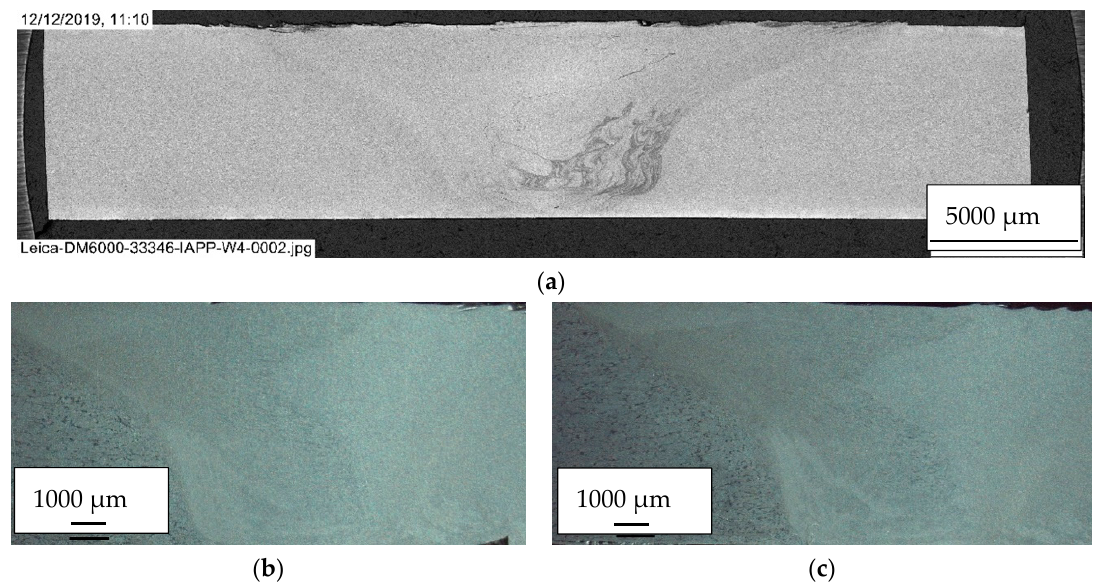
Figure 10. ( a ) Longitudinal weld performed in the C shape, ( b ) advancing side and ( c ) retreating side of the bracket weld. Higher magnification macrographs of the bracket weld around the thermomechanical affected zone (TMAZ) of the right-side show material flow in accordance with the movement of the probe, and the differences between grains due to the dynamic recrystal- lization tested in FSW (Figure 11).